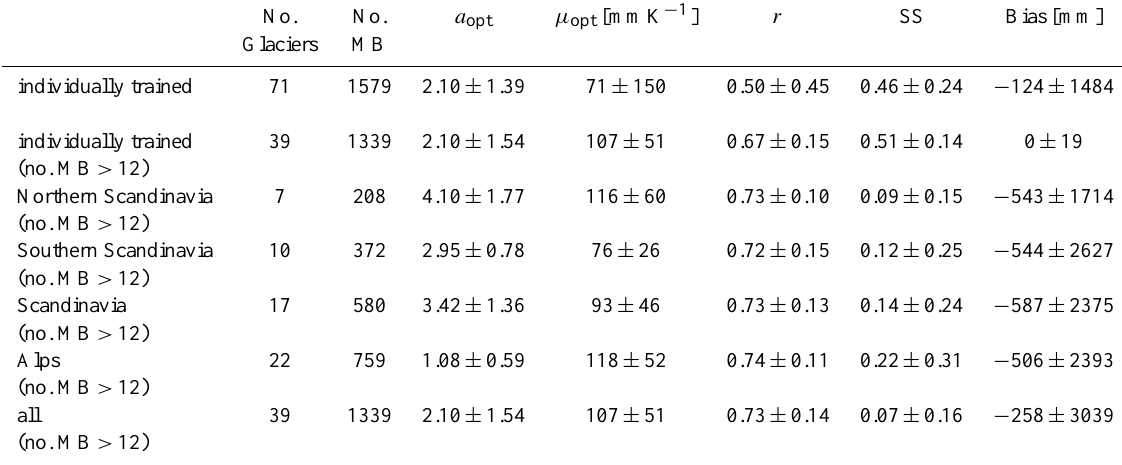
Table 1. Summary of parameters and cross validation results of the individually trained (first two lines) and the mean model (remaining lines). Number of glaciers with mass balance measurements, and total number of mass balance measurements are also given. All parameter values ( a opt and µ opt ), correlations ( r ), skill scores (SS), and biases given are the mean values obtained during the cross validation procedure, with their standard deviation. Negative skill scores imply zero skill and have, therefore, been replaced with zero for the calculation of the mean and standard deviation of the skill